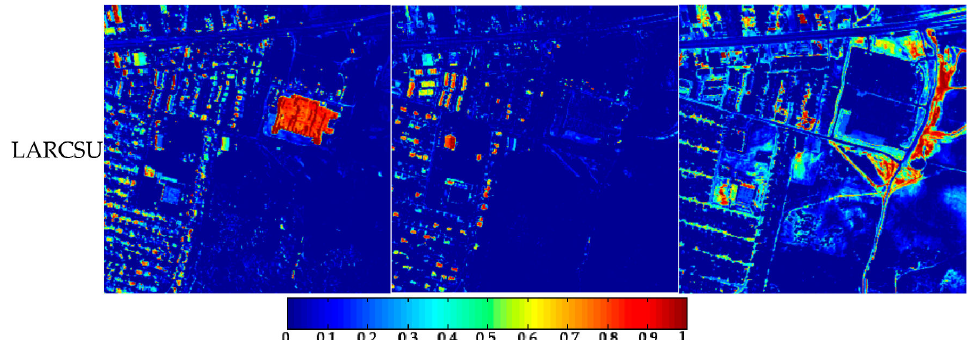
Figure 11. Estimated abundances of the different components for R-3.